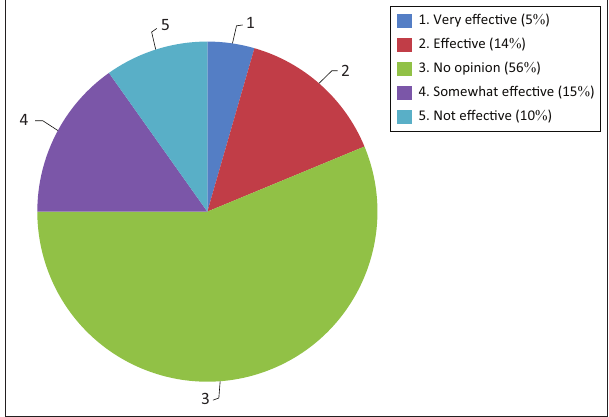
FIGURE 3: Participants’ opinions on coaching for knowledge transfer in organisations ( n = 112).